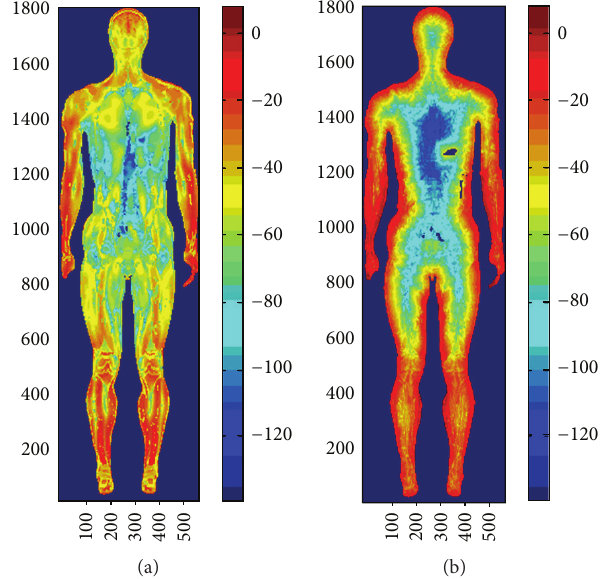
Figure 4: Whole body SAR (dB